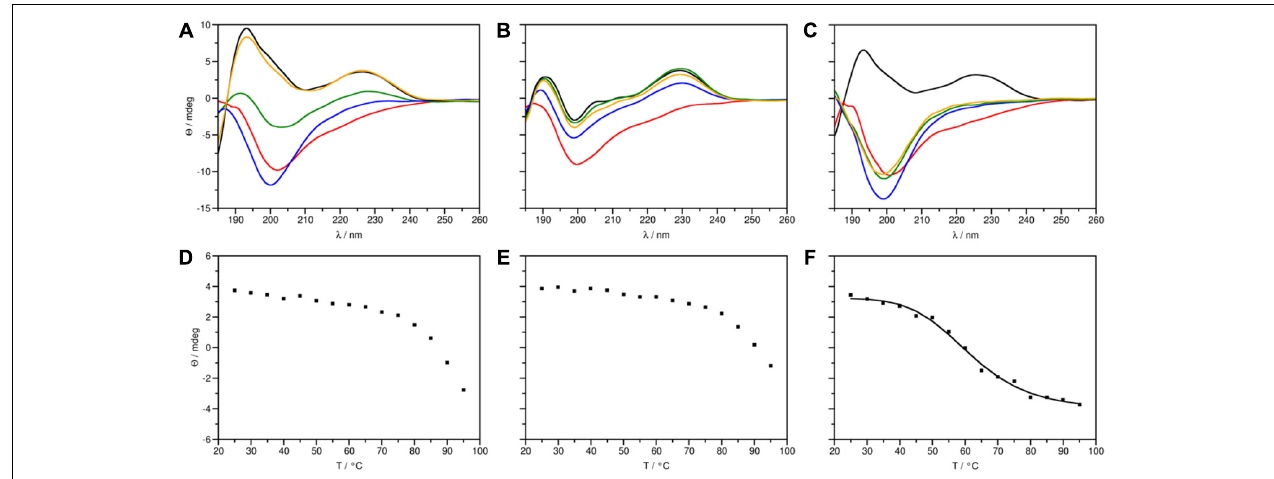
FIGURE 2 | ECD spectra (top panels) and thermal unfolding curves (bottom panels) of PAF protein variants. (A, D) PAF [data taken from Sonderegger et al. (2016)], (B, E) PAF var and (C, F) PAF opt . (A–C) Spectra in the 185–260 nm region were measured at 25 (black), 95 (red), and at 25 ◦ C directly (blue), 72 h (green), and 4 weeks (orange) after annealing. (F) PAF opt : T m = 61.39 ◦ C, R 2 = 0.9936.